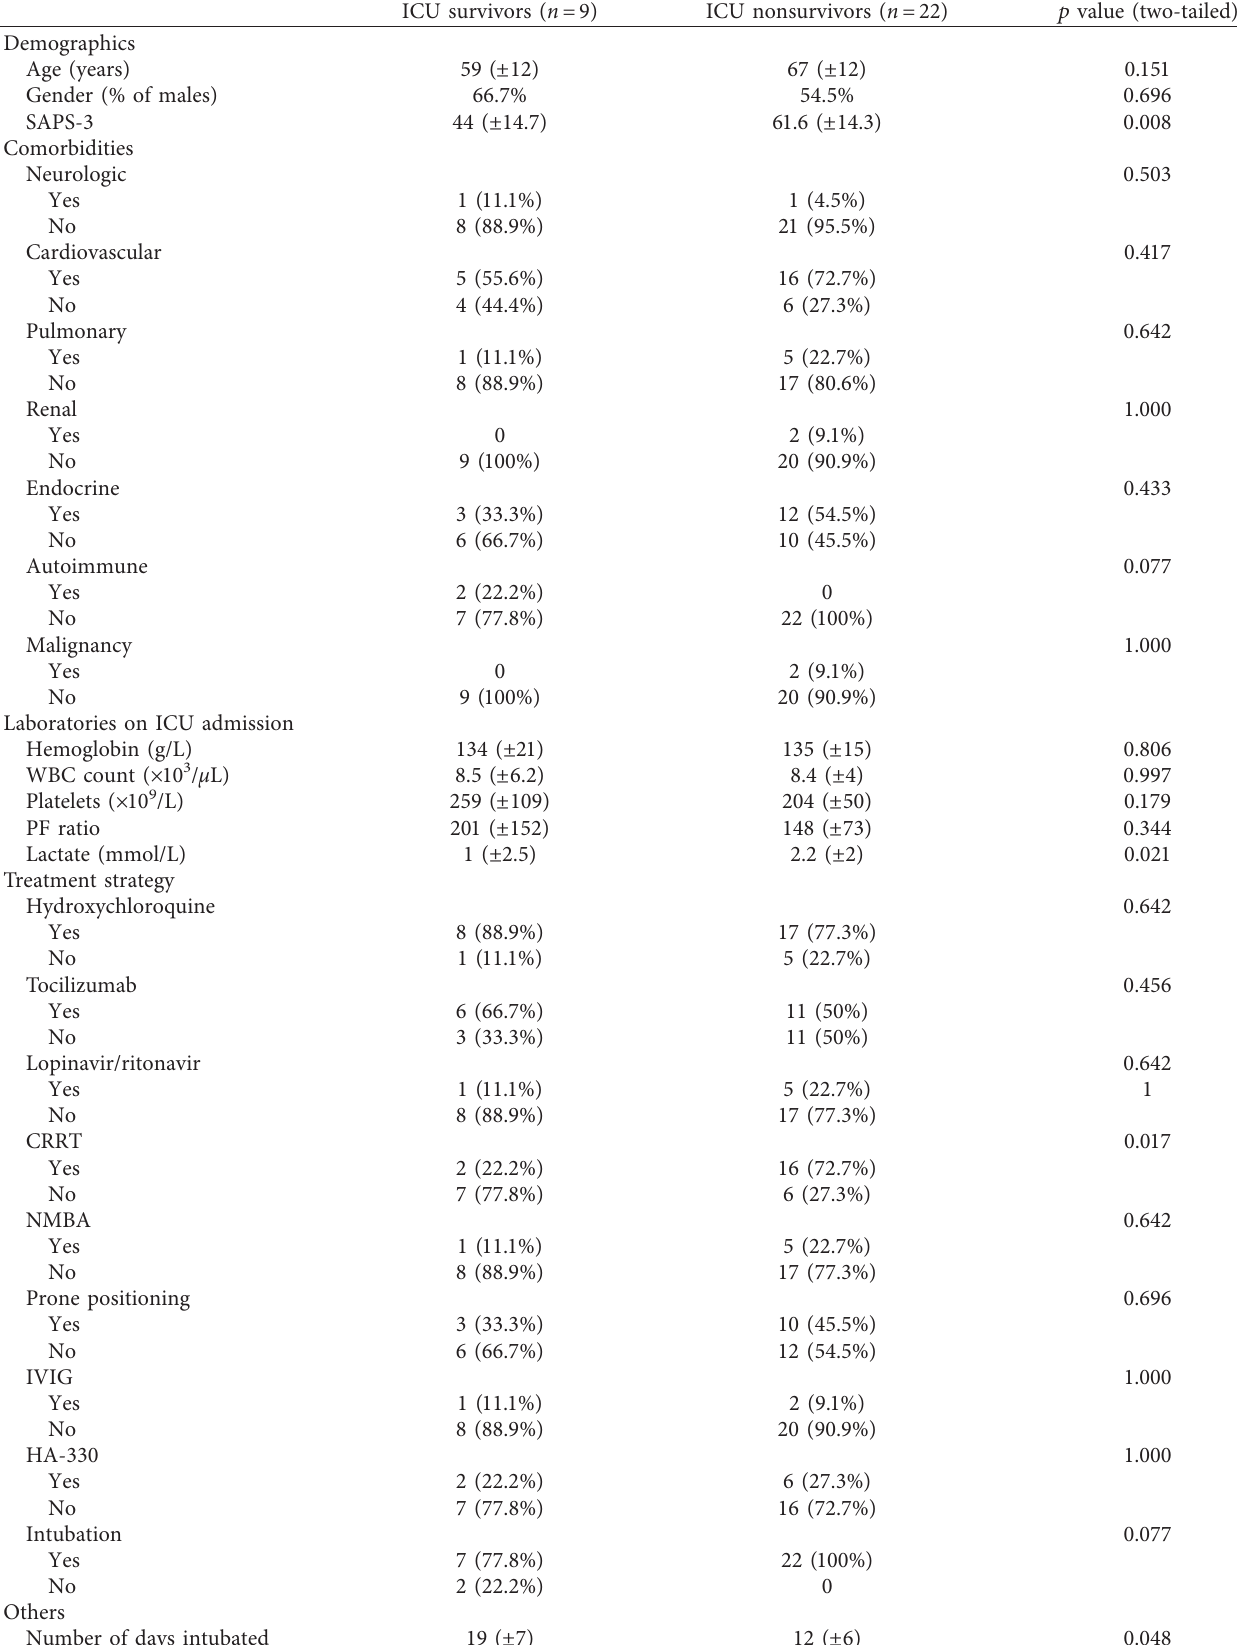
Table 4: Variables and outcomes among COVID-19-confirmed